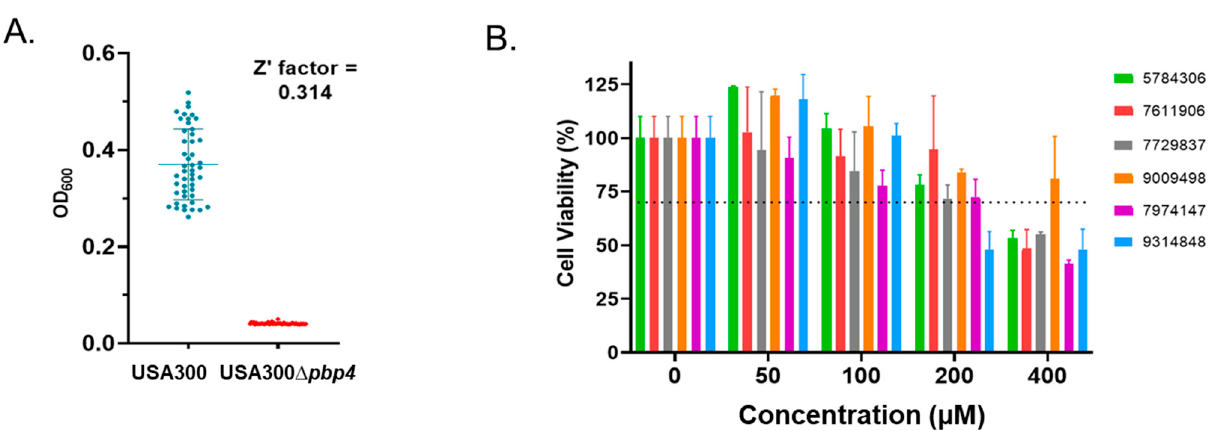
Figure 1. S. aureus PBP4 screening strategy and mammalian cell cytotoxicity of prioritized hits.